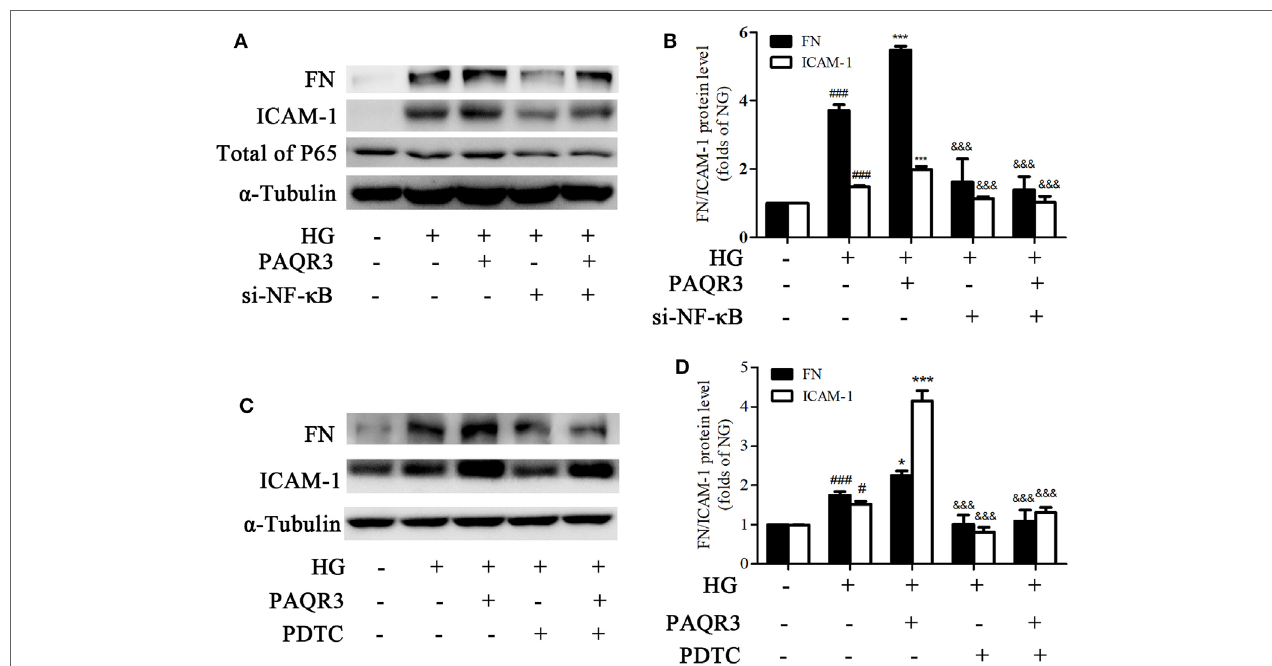
FigUre 8 | Genetical and pharmacological inhibition of NF- κ B attenuated the effects of progestin and adipoQ receptor 3 (PAQR3) overexpression on high glucose (HG)-induced upregulation of fibronectin and intercellular adhesion molecule-1. Glomerular mesangial cells (GMCs) were transfected with si-NF- κ B and PAQR3 plasmid for 24 h, then treated with HG for 24 h and total proteins were harvested to Western blot assay (a,B) . ### P < 0.001 vs. NG, *** P < 0.001 vs. HG, &&& P < 0.001 vs. HG + PAQR3. GMCs were transfected with PAQR3 plasmid for 24 h, and then treated with PDTC (10 µM) under HG conditions for 24 h (c,D) . Total proteins were harvested to Western blot assay. # P < 0.05, ### P < 0.001 vs. NG, * P < 0.05, *** P < 0.001 vs. HG, &&& P < 0.001 vs. HG + PAQR3. Independent experiments were performed at least three times with similar